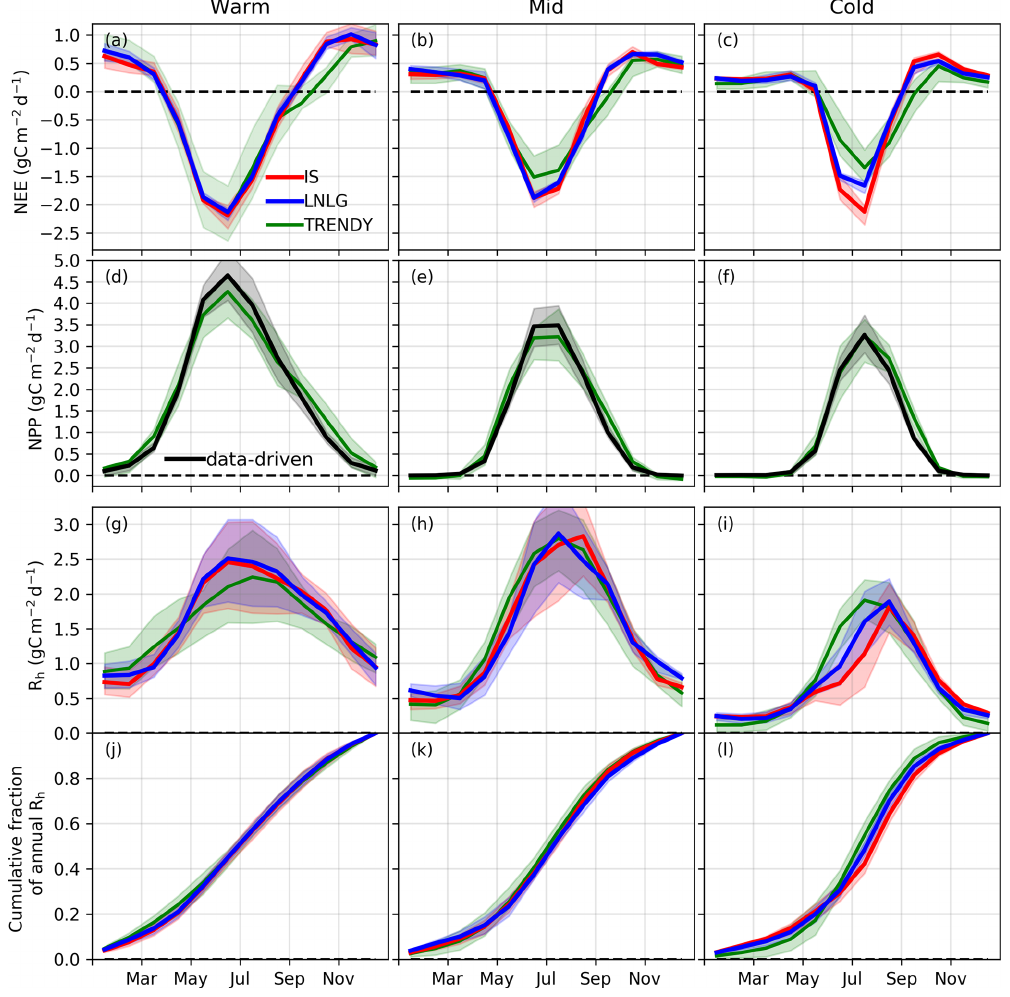
Figure 3. Monthly carbon cycle fluxes (average of 2015, 2016, and 2018; 2017 is excluded due to an OCO-2 data gap). (a–c) Mean (solid line) and interquartile range (shaded area) of NEE for the ensemble of IS (red) and LNLG (blue) v9 OCO-2 MIP and for the TRENDY ensemble (green). (d–f) NPP for the TRENDY ensemble (green) and estimated from data-driven GPP (black). (g–i) R h simulated by the TRENDY ensemble (green) and calculated from combining the data-driven NPP with the IS (red) and LNLG (blue) v9 OCO-2 MIP NEE constraints. (j–l) Cumulative fraction of R h over the growing